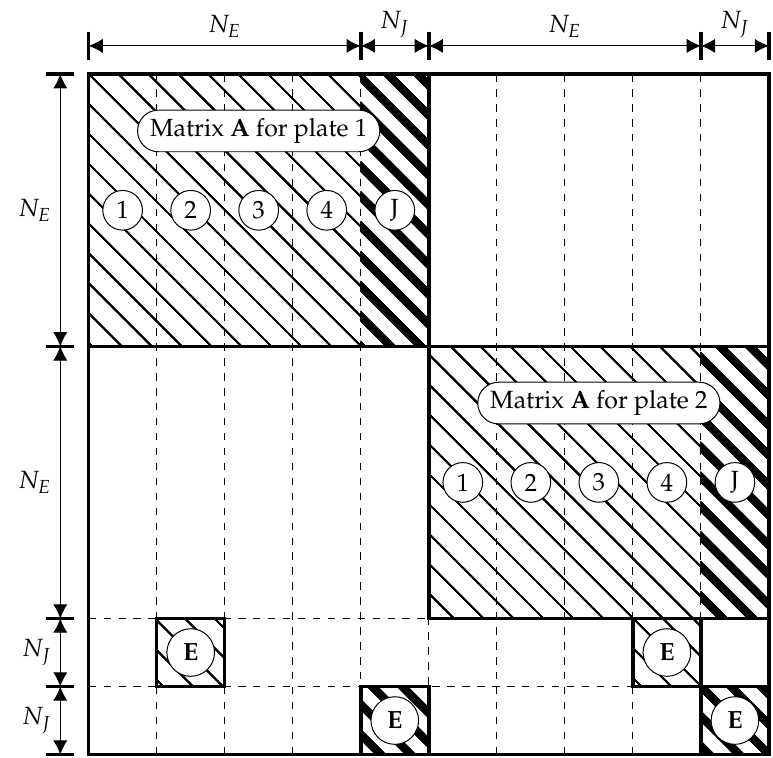
Figure 4. The A matrix for the assembled plate structure in Figure 3. For an assembled plate structure, the plates are joined together by junction lines, as shown in Figure 3. The junction line is along the x 2 -axis. Each plate has its own local set of coordinates ( x i , x i , x i ) with i = 1, 2, . . . , N , where N is the number of plates. To account 2 3 1